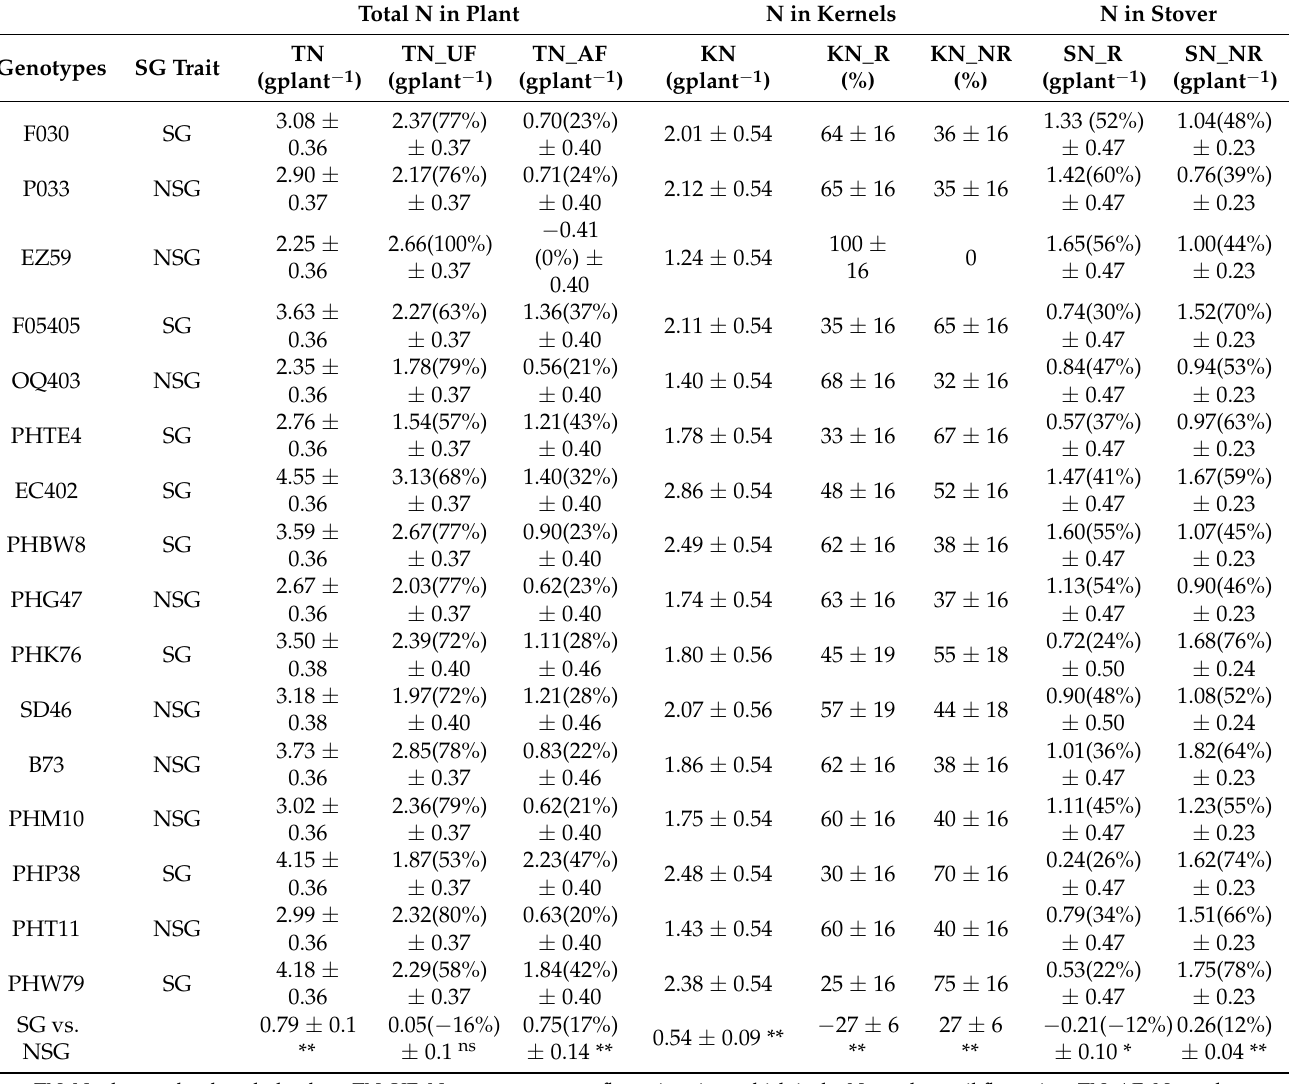
Table 2. Total N content at silking time and physiological maturity of plant stover (leaf and stem), N content in grain, and N remobilization and uptake by grain of 16 maize inbred lines of four flowering groups from flowering time, evaluated in 2017 in two locations in